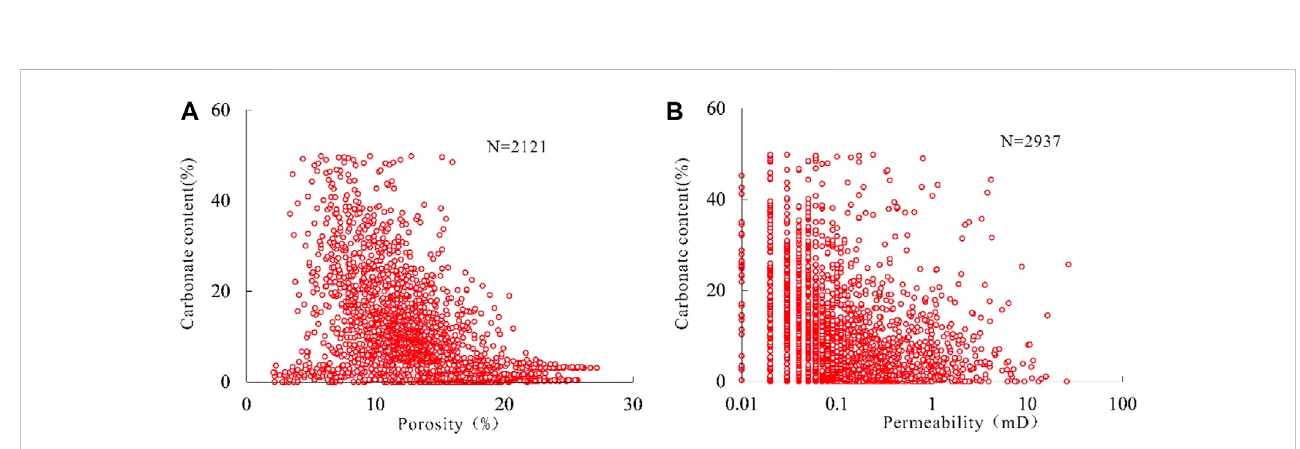
FIGURE 12 Relationship of (A) porosity and (B) permeability with carbonate content of the Gaotaizi oil layer.